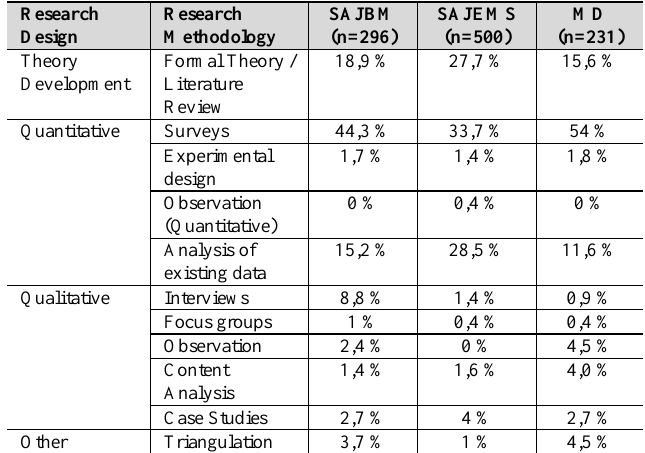
Table 8: Research methodology of articles in each journal over all fifteen years